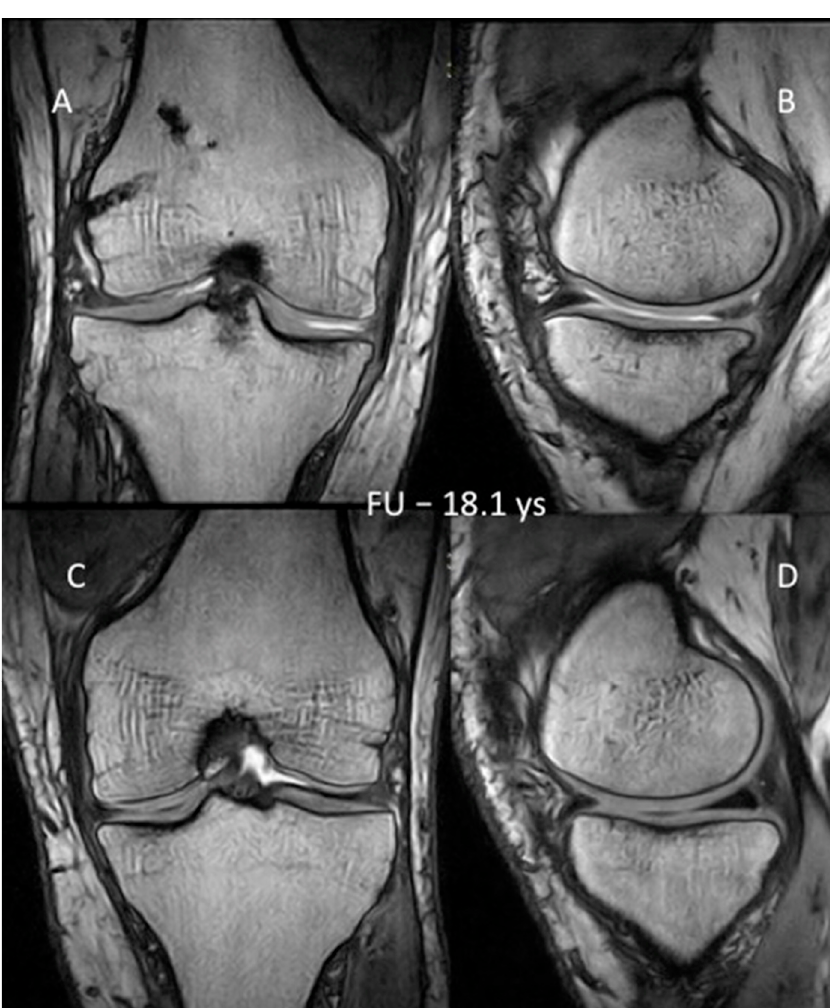
Figure 6. ( A ) MRI scan of the SA knee after ACL-R (frontal plane) obtained during the first follow-up (Patient 3); ( B ) MRI scan of the SA knee after ACL-R (sagittal plane of MFC) obtained during the first follow-up (Patient 3); ( C ) MRI scan of the control knee (frontal plane) obtained during the first follow-up (Patient 3); ( D ) MRI scan of the control knee (sagittal plane of MFC) obtained during the first follow-up (Patient 3). MRI, magnetic resonance imaging; SA, septic arthritis; ACL-R, anterior cruciate ligament reconstruction; MFC, medial femoral condyle. 18.1 years follow-up. Table 4. Knee joint cartilage thickness in MRI images. Knee Cartilage Thickness